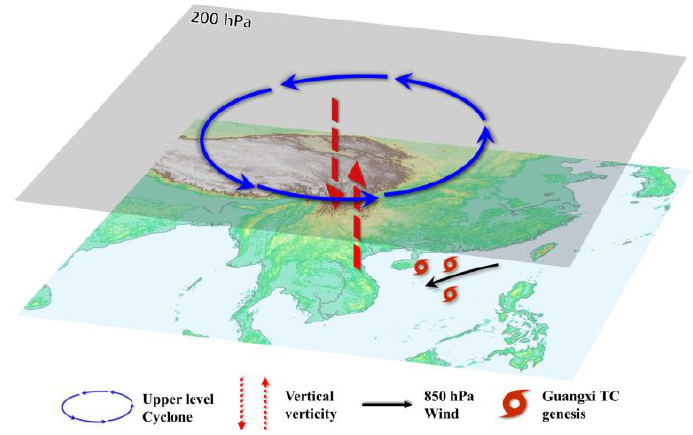
Figure 6. A schematic diagram of the impacts of thermal forcing over the southeast TP on the frequency of tropical cyclones affecting Guangxi formed within the west of 120° E.